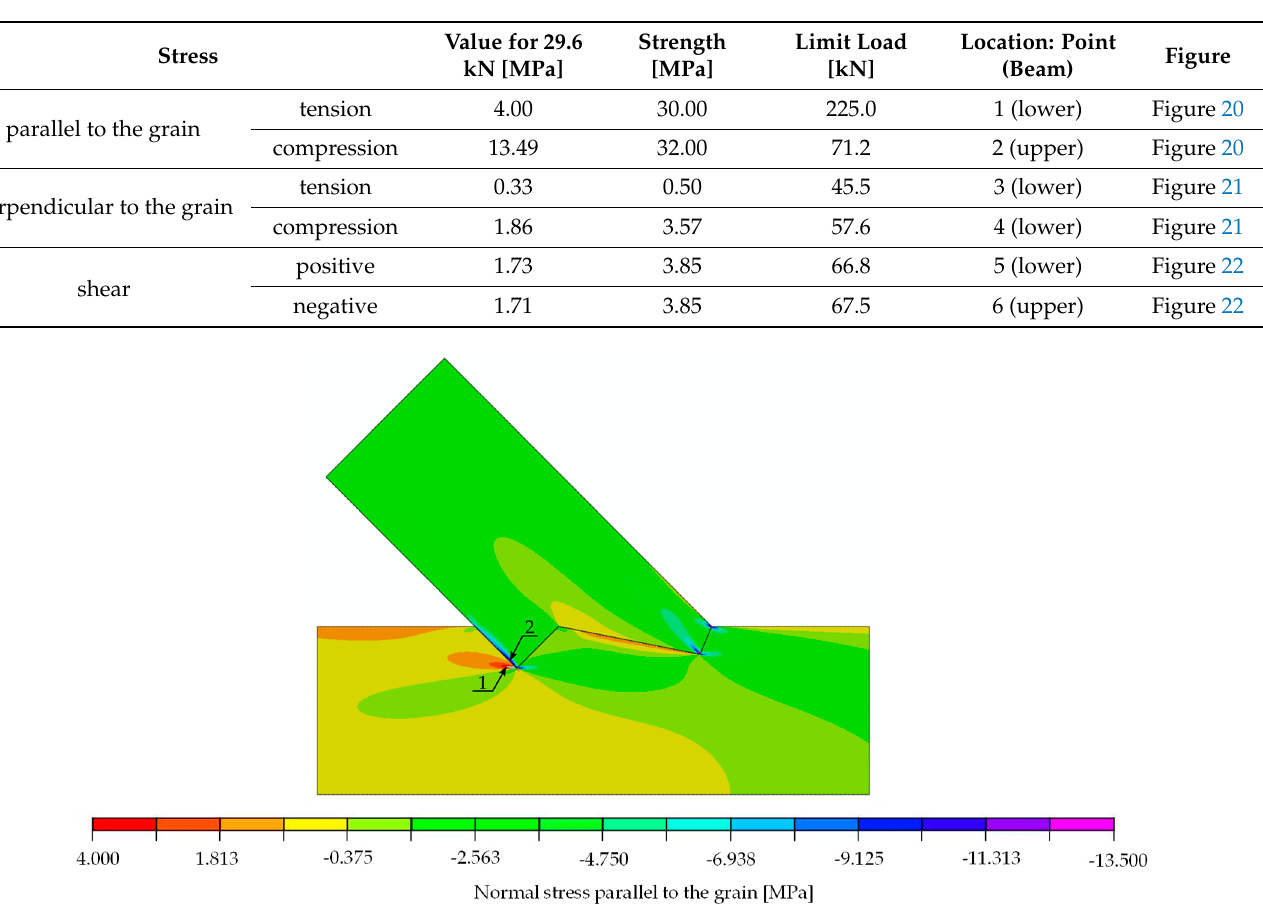
Figure 20. Double-step joint FEM modelling - normal stress parallel to the grain [MPa]. Force 29.6 kN.